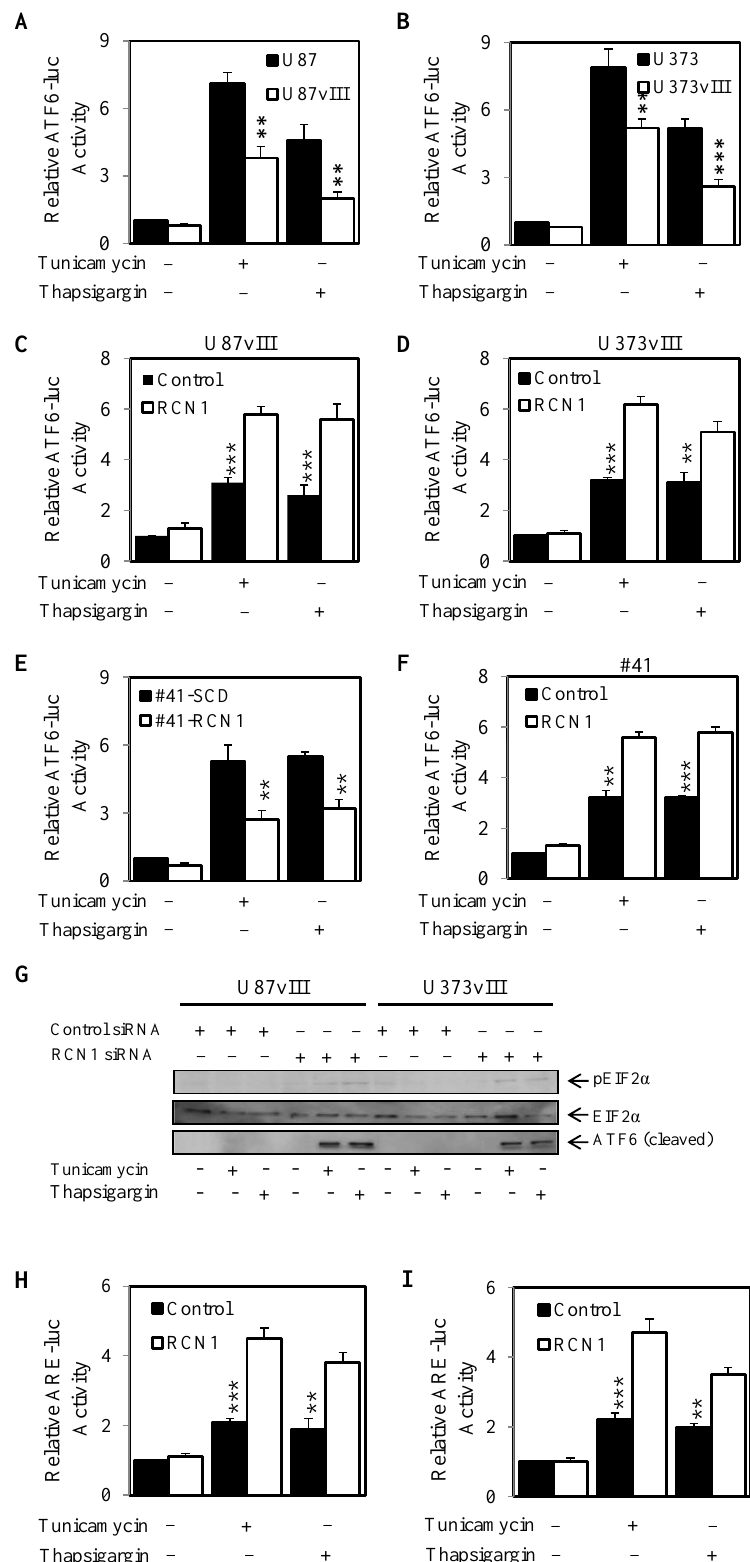
Figure 5. RCN1 expression inhibits Er stress response. ( A ) U87 and U87vIII and ( B ) U373 and U373vIII cells were transfected with the ATF6 luciferase reporter construct and allowed to adhere overnight. Cells were then treated with ± tunicamycin (50 nM) or ± thapsigargin (50 nM) for a further 24 h, lysed and assessed for luciferase activity. Data are expressed as relative luciferase activity (fold change) by standardizing the luciferase activity of the control untreated cells to 1, and ac- cordingly normalizing all other raw values. ( C ) U87vIII and ( D ) U373vIII cells were transfected